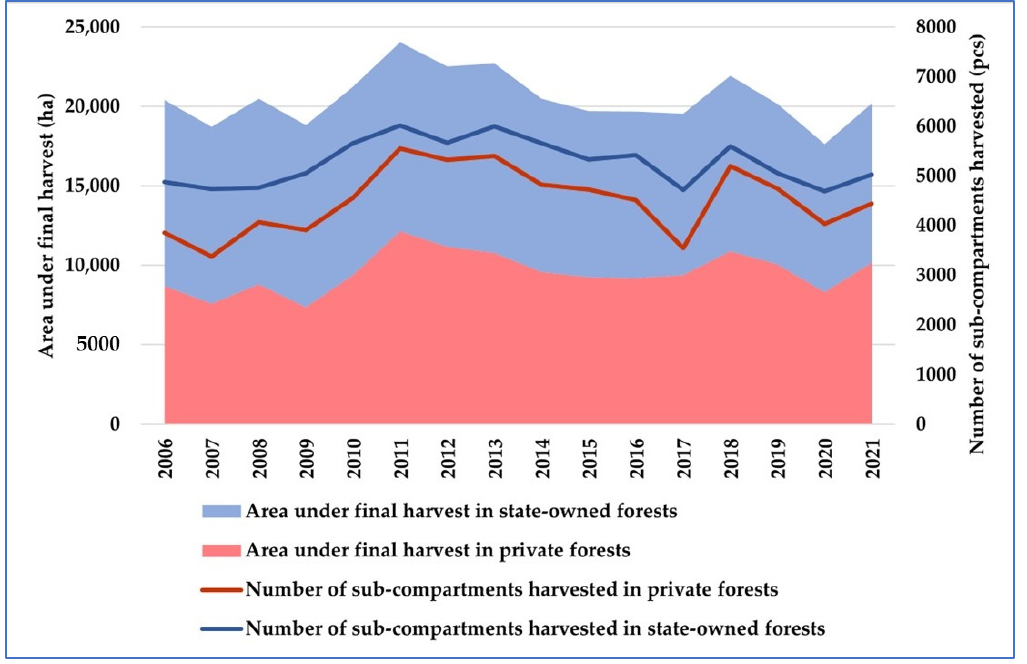
Figure 2. Area under harvest and the number of sub-compartments harvested in state-owned and private forests in the period 2006–2021.